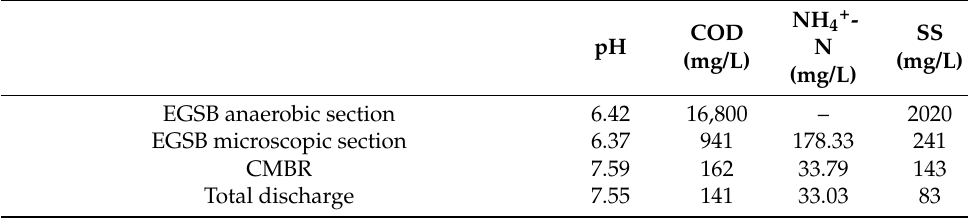
Table 3. Treatment performance of each unit.